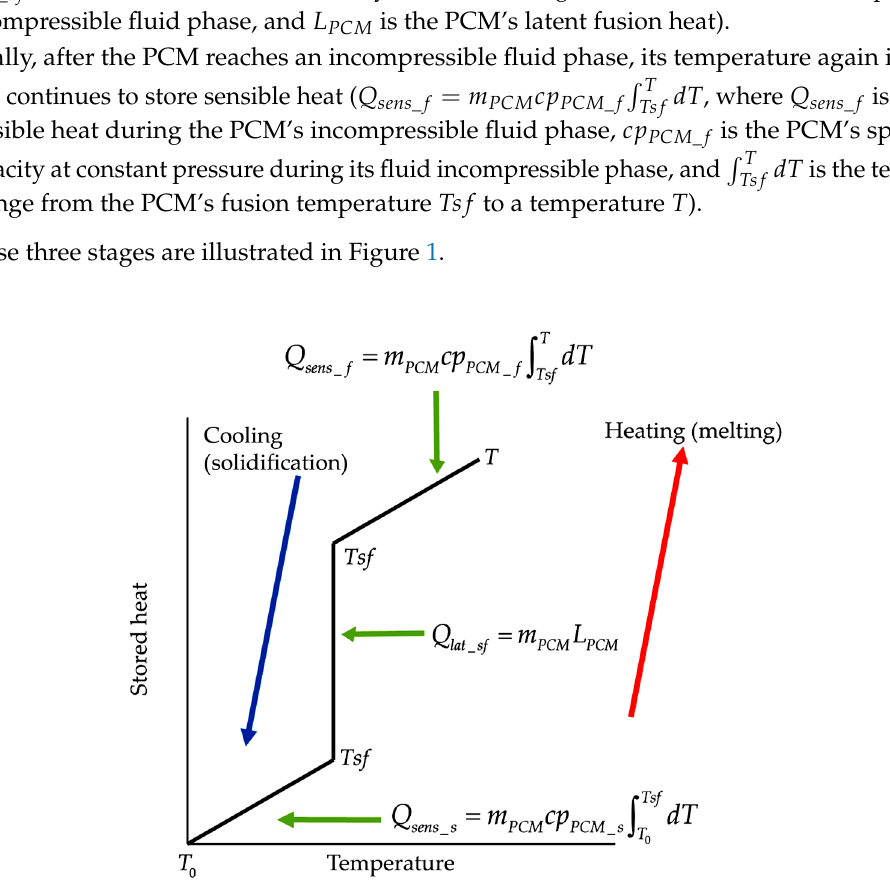
Figure 1. Heat storage stages of a phase change material (PCM).